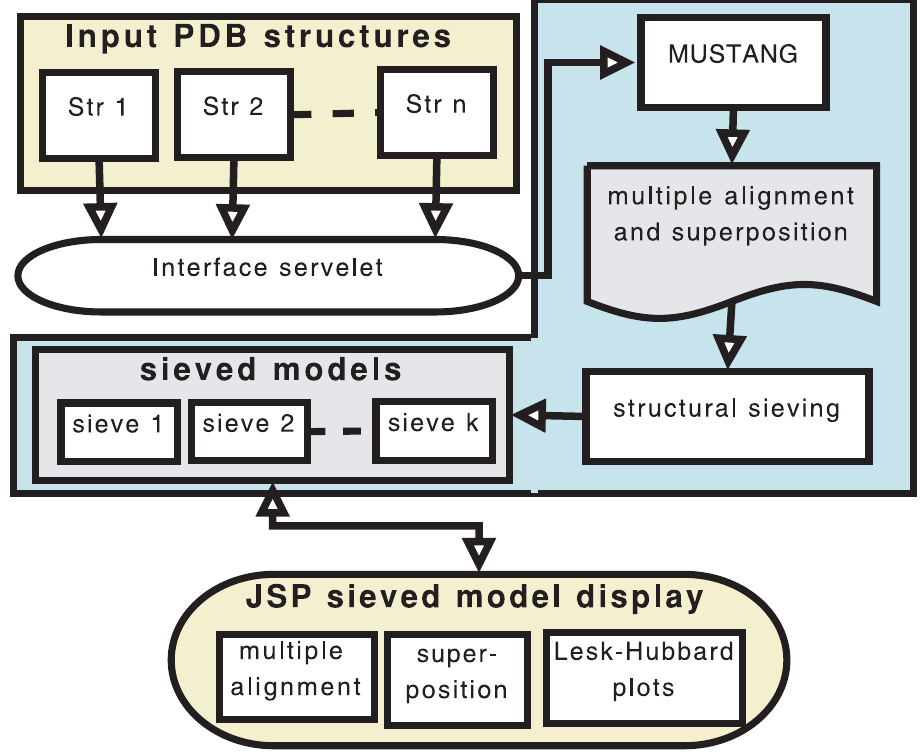
Figure 1. Overview of MUSTANG structural sieving server.